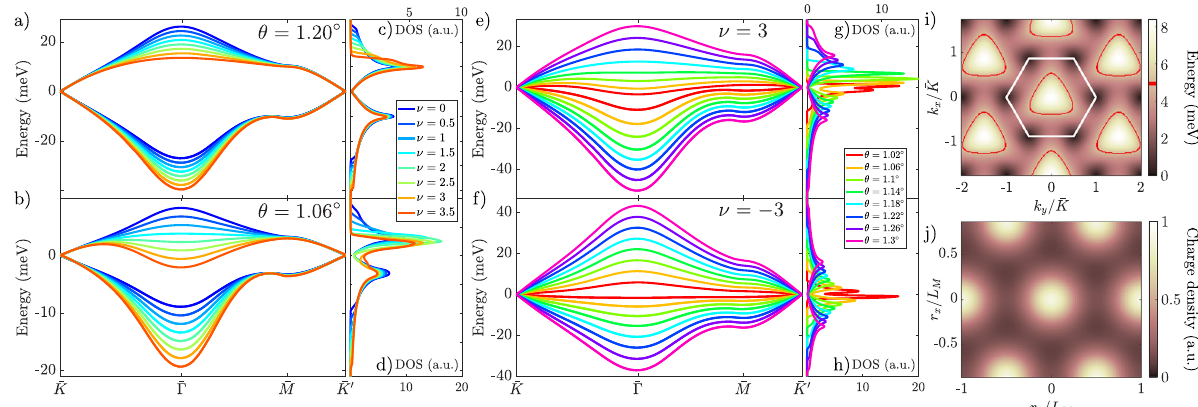
Fig. 1 Hartree-Fock renormalized bandstructures. TBG bandstructures as a function of fi lling for a θ = 1.2°, and b θ = 1.06° after including the HF corrections. One of the important features is related to band fl attening and eventual inversion at the Γ point of the MBZ. The energy dependence of the density of states ( c , d , g , h ), demonstrating maximal enhancement when the band gets fl attened, is shown next to each bandstructure. TBG bandstructures including HF corrections as a function of twist angle for e ν = 3, and f ν = − 3, respectively. In ( a , b , e , f ) we plot bandstructures for the ξ = − 1 valley. i The noninteracting energy landscape in the extended zone scheme of an electron band for ξ = − 1 at θ = 1.06 ∘ . One MBZ is shown as a white hexagon. With red energy contour we denote Fermi surface for ν = 3. j Charge density for a noninteracting bandstructure corresponding to E F = 4.92 meV corresponding to the red energy contour in ( i ) and a fi lling of ν ≈ 3. Note that even at this large fi lling majority of charge density is located on the AA sites of the effective triangular lattice giving rise to the large Hartree potentials. Here charge density is normalized by the highest charge density at full fi